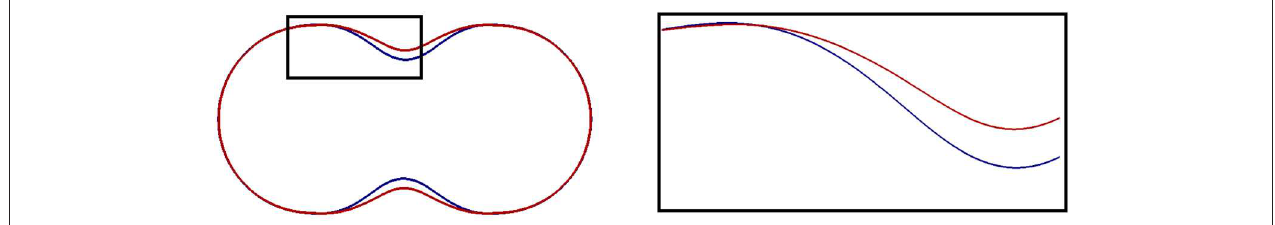
0.85 (red). The latter effectively =